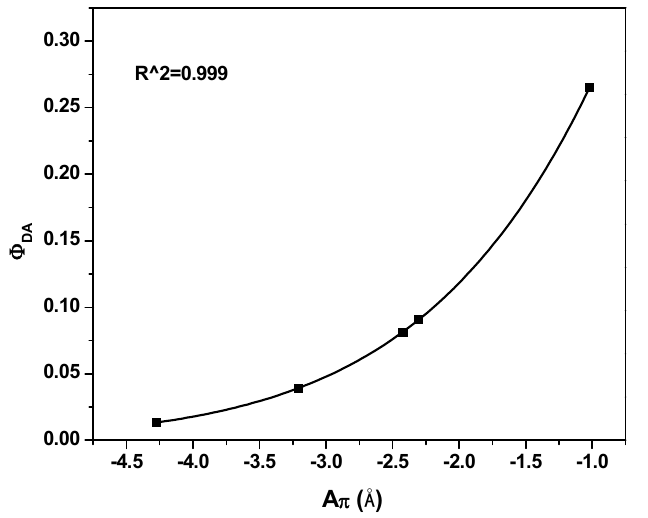
Figure 7. Fluorescence quantum yield versus the conjugated length for PFO/MEH-PPV with various ratios of STNCs.